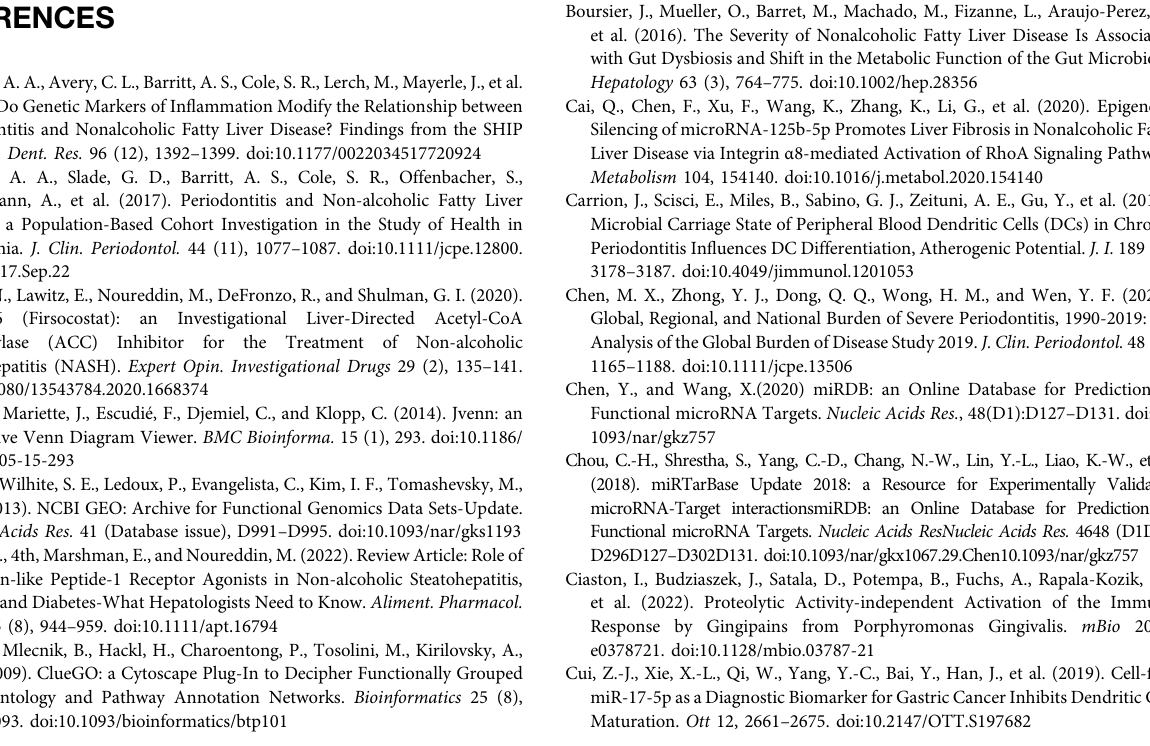
Supplementary Data S1 | All differential genes (DEGs) from health and disease